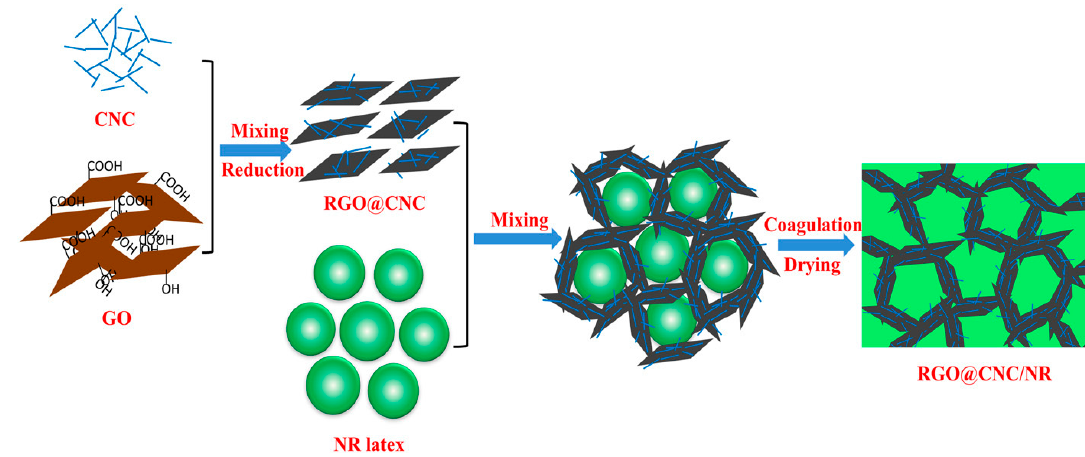
Figure 16. Schematic presentation of the synthesis of CNC/RGO/NR nanocomposite. Reproduced with permission from Reference [182]. Copyright ©2016, Elsevier.